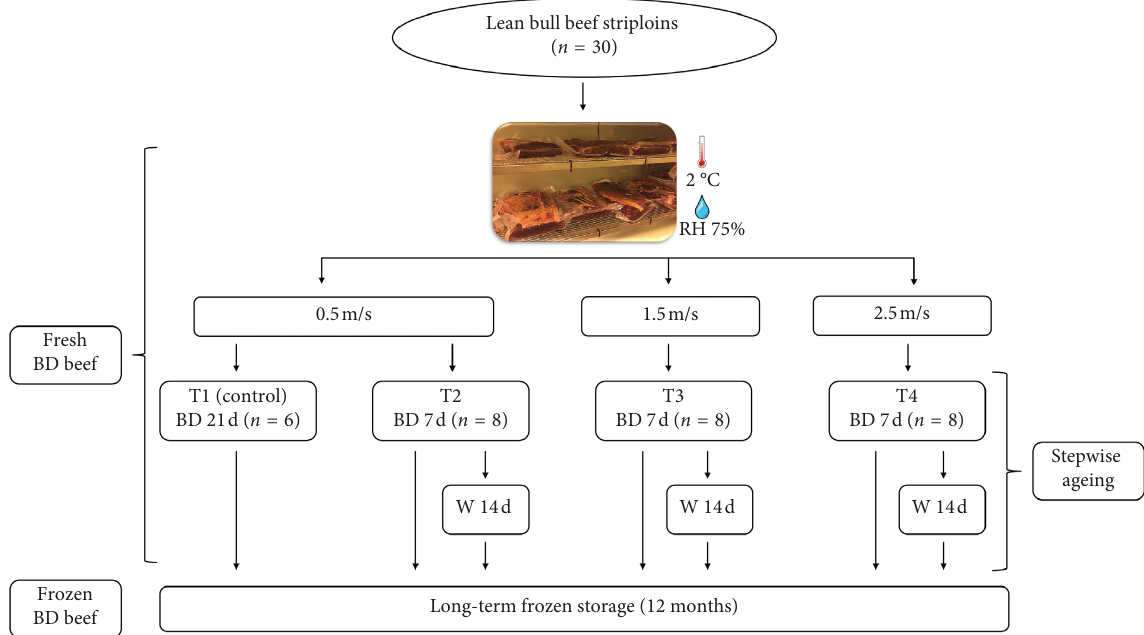
Figure 1: Schematic illustration of the ageing process and treatment combinations in the current study. BD: in-bag dry-ageing; W: wet- ageing; T1: BD at 0.5m 7d +W for